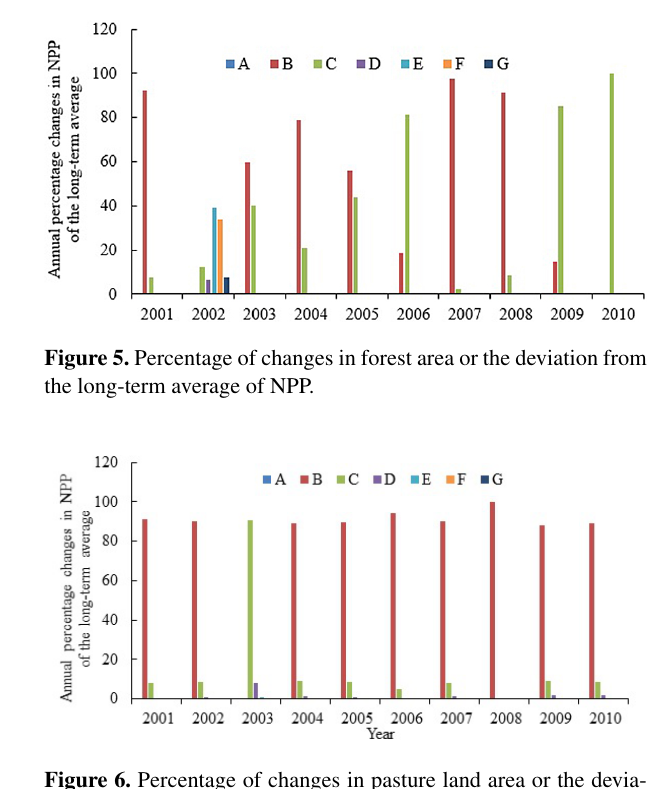
Figure 6. Percentage of changes in pasture land area or the devia- tion from the long-term average of